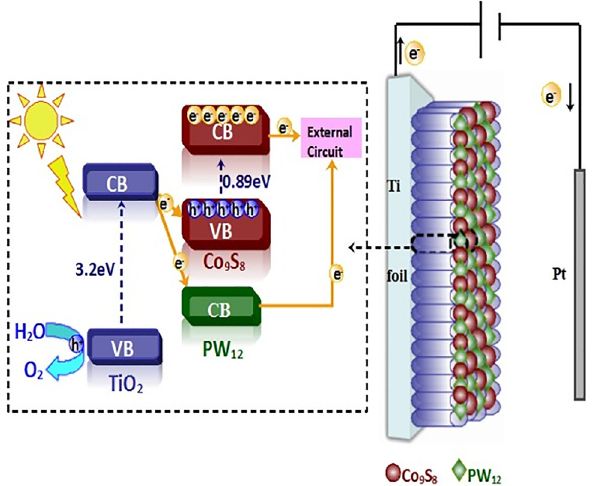
Figure 19: Schematic diagram showing electron transfer from CB of TiO 2 to the CB of PW 12 and VB of Co 9 S 8 . Adopted with permission from ref. [166].